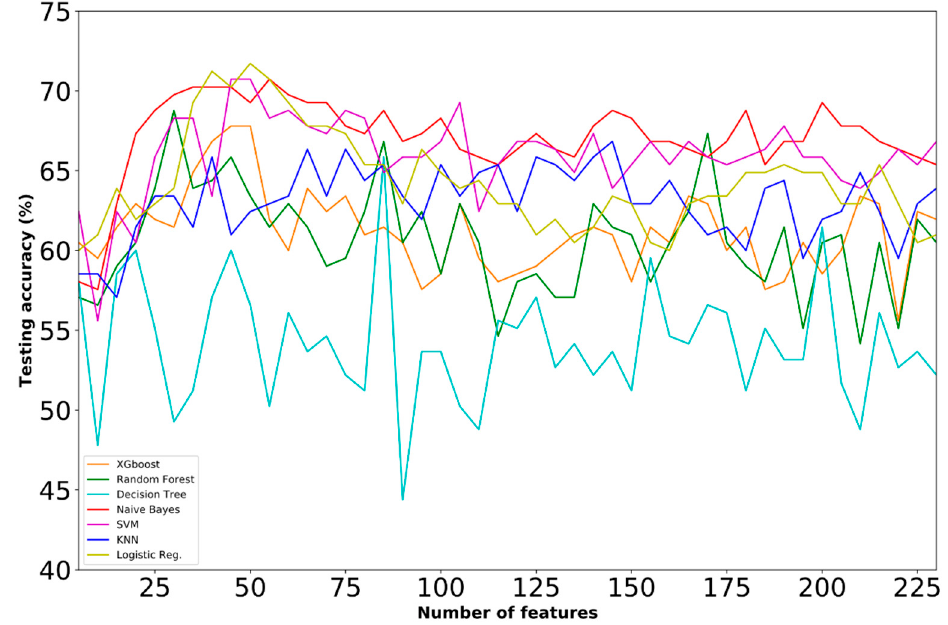
Figure 7. Learning curves with testing accuracy scores on dataset A for different machine learning (ML) models trained on feature subsets of increasing dimensionality. Table 4. Best testing accuracies achieved for ML model along with the confusion matrix, the optimum number of features and the hyperparameters of the ML models employed. A1 and A2 denote classes 1 and 2 of dataset A,